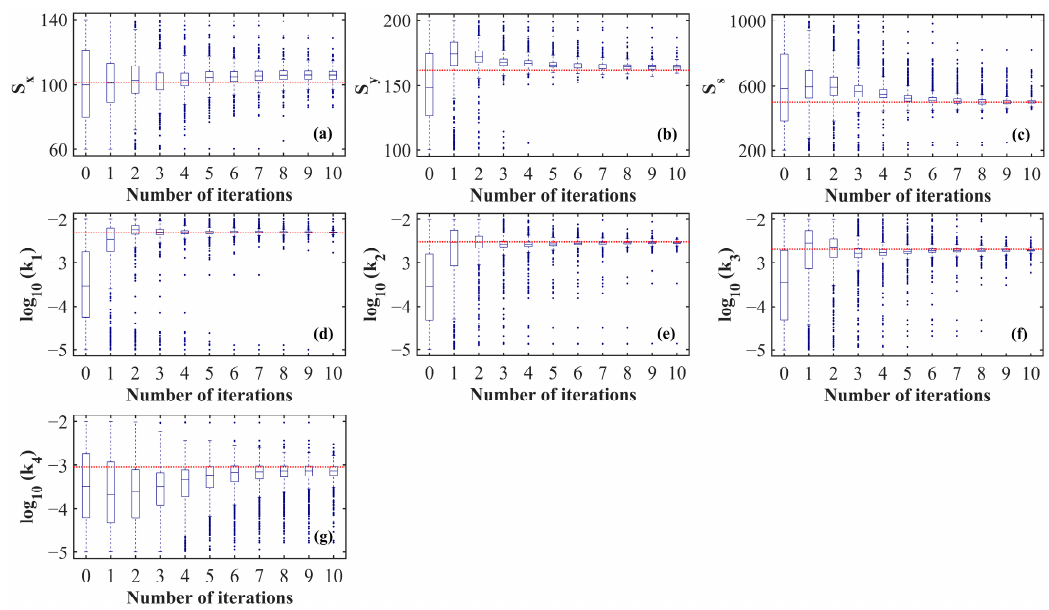
Figure 12. Box plots of model parameters estimated by ensemble smoother with multiple data assimilation (ES-MDA) in Case 3: ( a,b ) source location ( S x , S y ) , ( c ) source strength ( S s ) , ( d – g ) the four rate constants ( k 1 , k 2 , k 3 , k 4 ) . The red dashed lines denote the reference true values of corresponding model parameters.